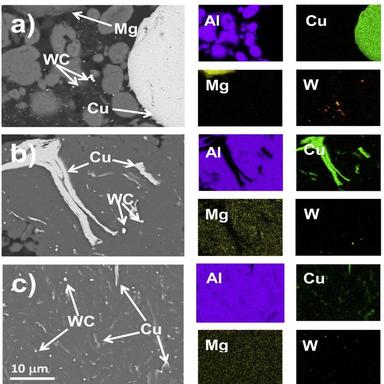
Cross-sectional SEM images and respective SEM-EDS elemental mapping images obtained from Al-Cu-Mg/WC composite powders after different milling times: a) 0 h, b) 3 h, and c) 5 h.